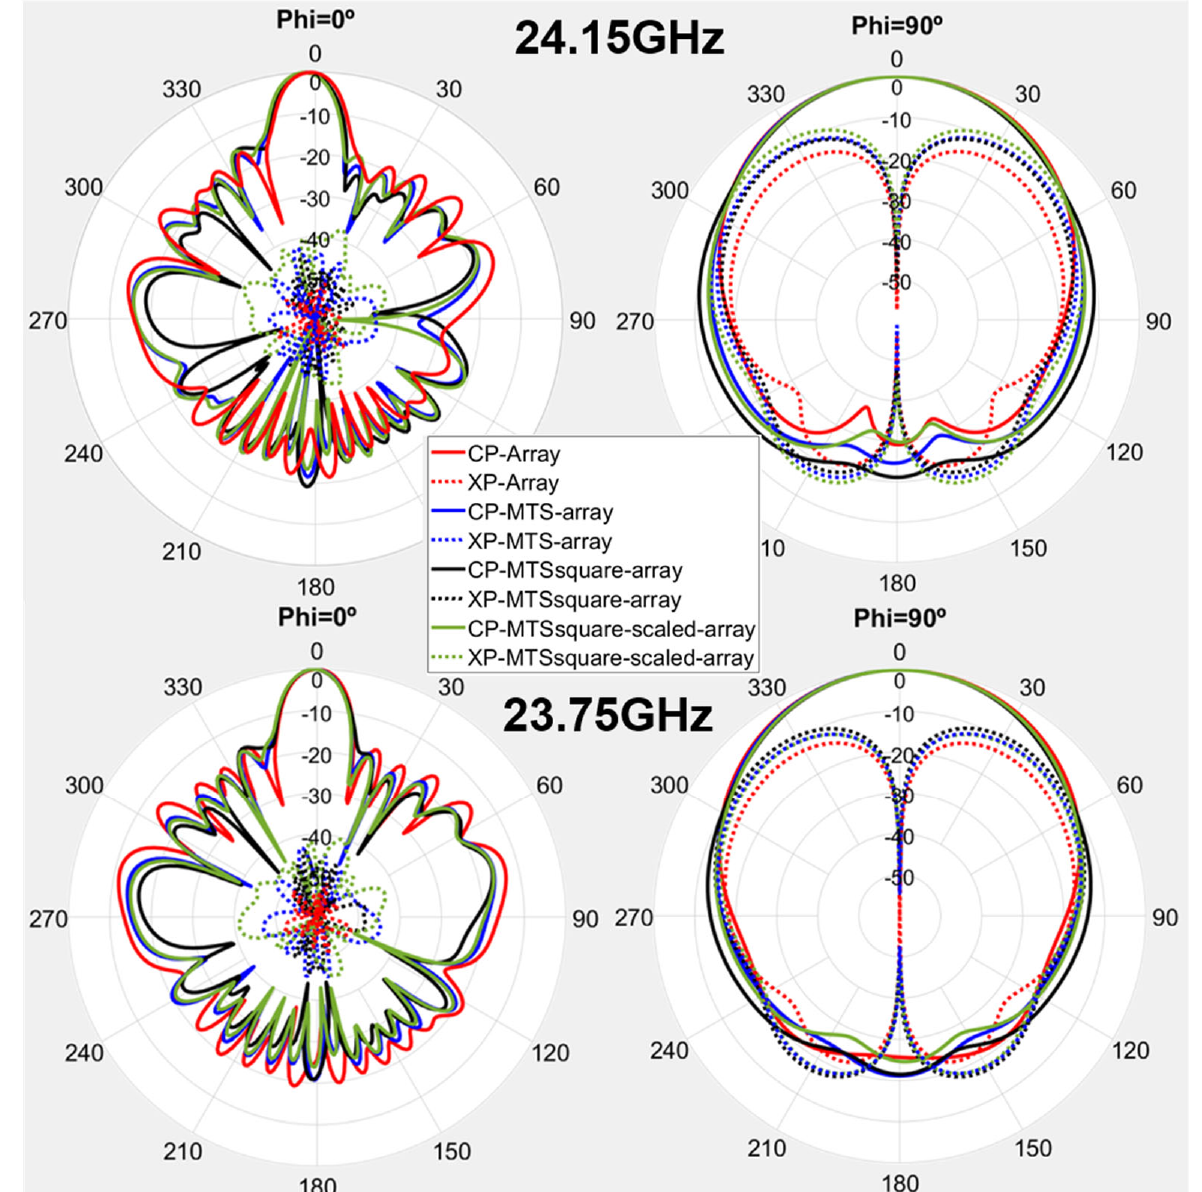
Figure 7. Radiation pa tt ern cuts for Phi = 0° and Phi = 90° at 24.15 GHz and 23.75 GHz for the antennas under analysis.